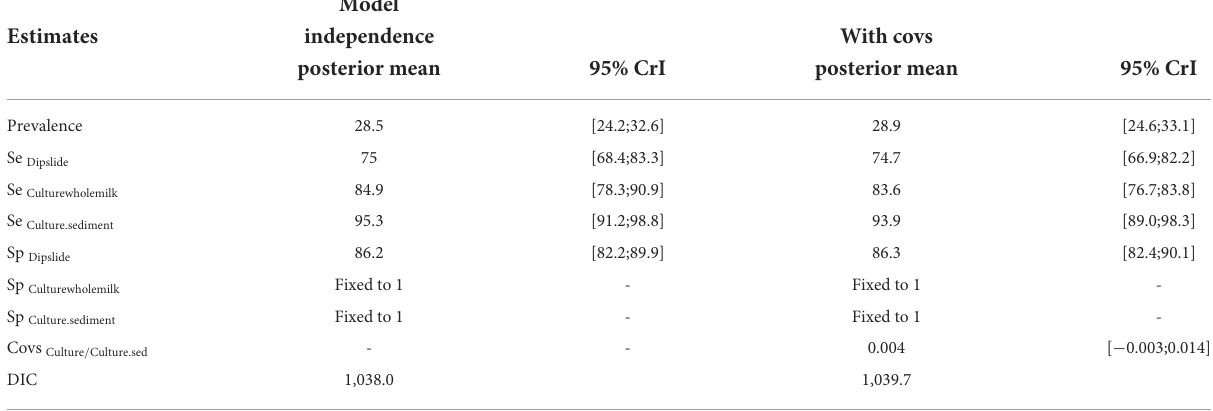
TABLE 3 Outcomes of the final BLCM evaluating test accuracies for Streptococcus uberis of a subset of the data including Dipslide, culture of whole milk and culture of milk